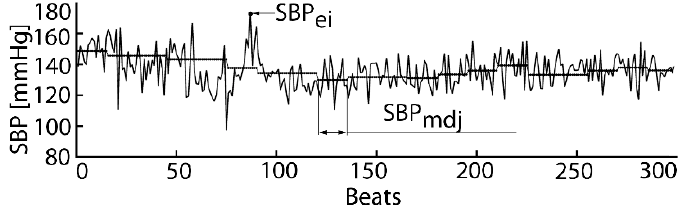
Figure 12. Estimated SBP ei blood pressure values (curved line) and SBP mdj median values (stepwise line), calculated from SBP ei in BPEW.